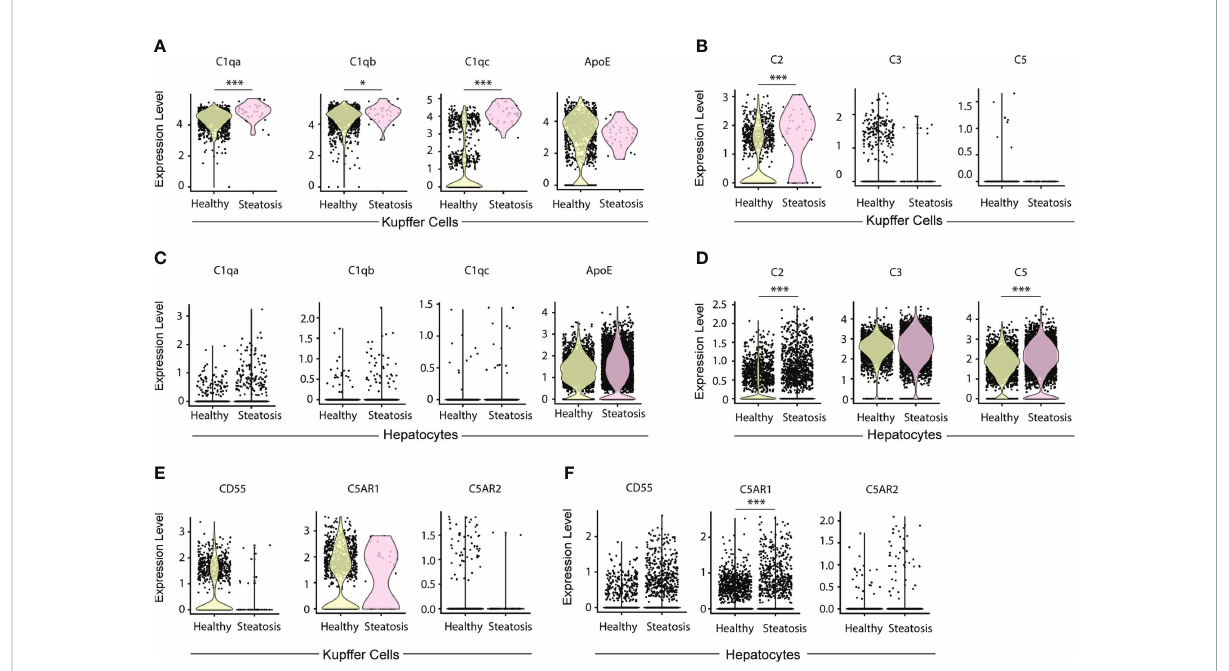
FIGURE 8 Expression of C1q, ApoE, and complement components in KCs and hepatocytes in human livers. (A, B) Violin plots show C1qa, C1qb, C1qc, and ApoE transcripts (A) and C2, C3, and C5 transcripts in KCs (B) in human livers. (C, D) Violin plots show C1qa, C1qb, C1qc, and ApoE transcripts (C) and C2, C3, and C5 transcripts in hepatocytes (D) in healthy and diseased livers. (E, F) Violin plots show CD55, C5AR1 and C5AR2 transcripts in KCs (E) and hepatocytes (F) in healthy and diseased human livers. Each point represents one cell. Data were analyzed by Wilcoxon rank